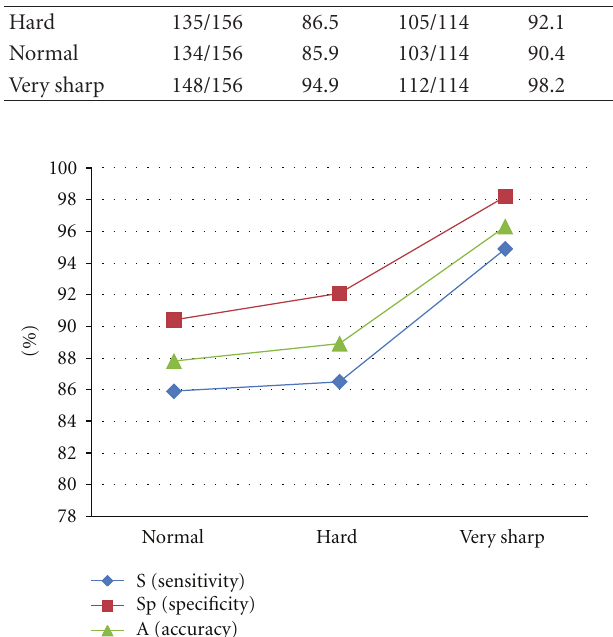
Figure 2: Evaluation of the sensitivity (S), specificity (Sp), and accuracy (A), according to the type of protocol, in the study of the presence or absence of simulated lesions.